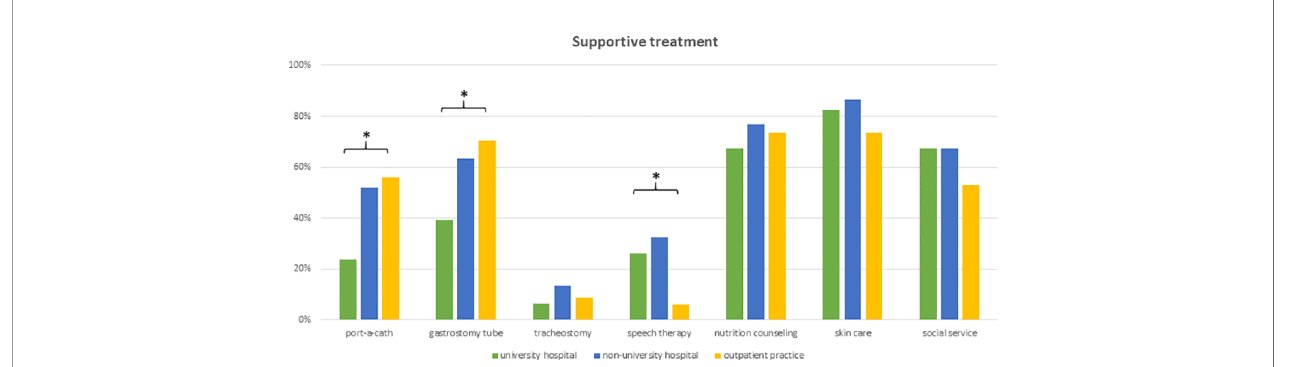
FIGURE 6 | Bar charts indicating the application of supportive interventions routinely used in the treatment of elderly HNSCC patients, separated for responders ’ type of facility (n=129). * indicating p <0.05 Pearson ’ s